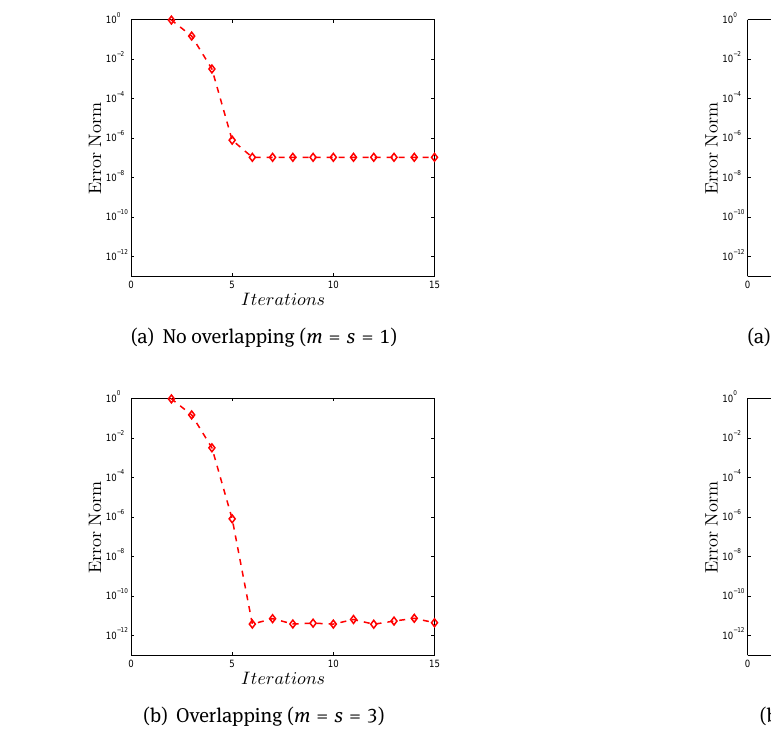
Figure 14: Convergence graphs for example 3 when t = 1 and N t = N x = 10.